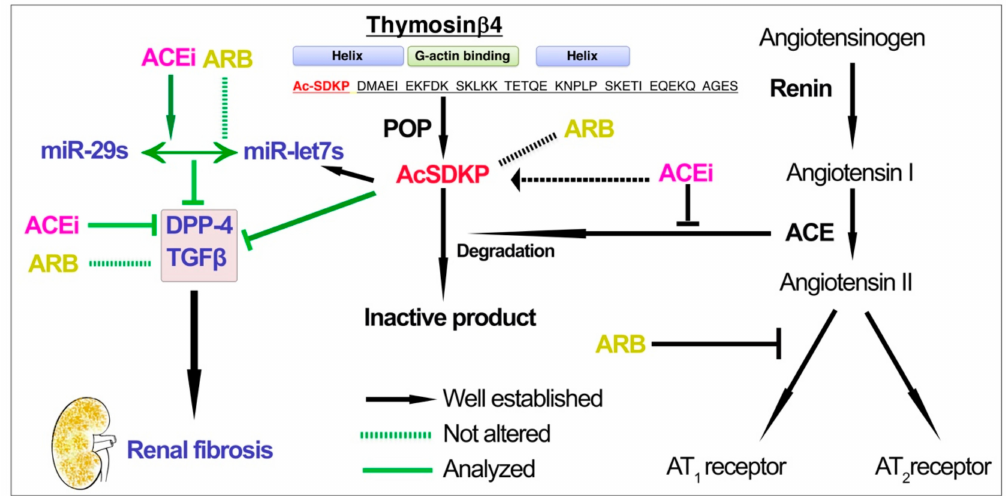
Figure 7. Working hypothesis for ACEi action on the suppression of DPP-4 associated fibrogenic program and restoration of antifibrotic microRNAs.